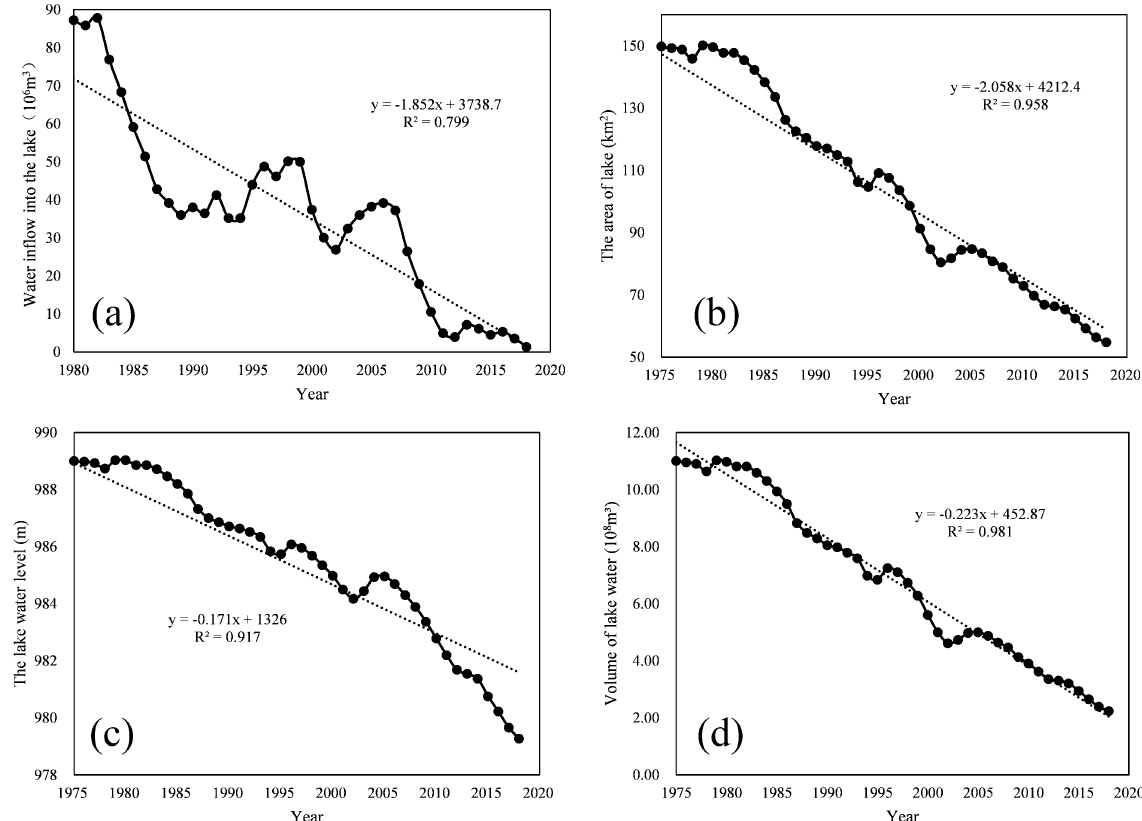
Figure 7. ( a ) Change of runoff in Daihai Lake over the years; ( b ) Changes of lake area in Daihai over the years; ( c ) Changes of lake water level in Daihai over the years; ( d ) Changes of volume water in Daihai Lake over the years.